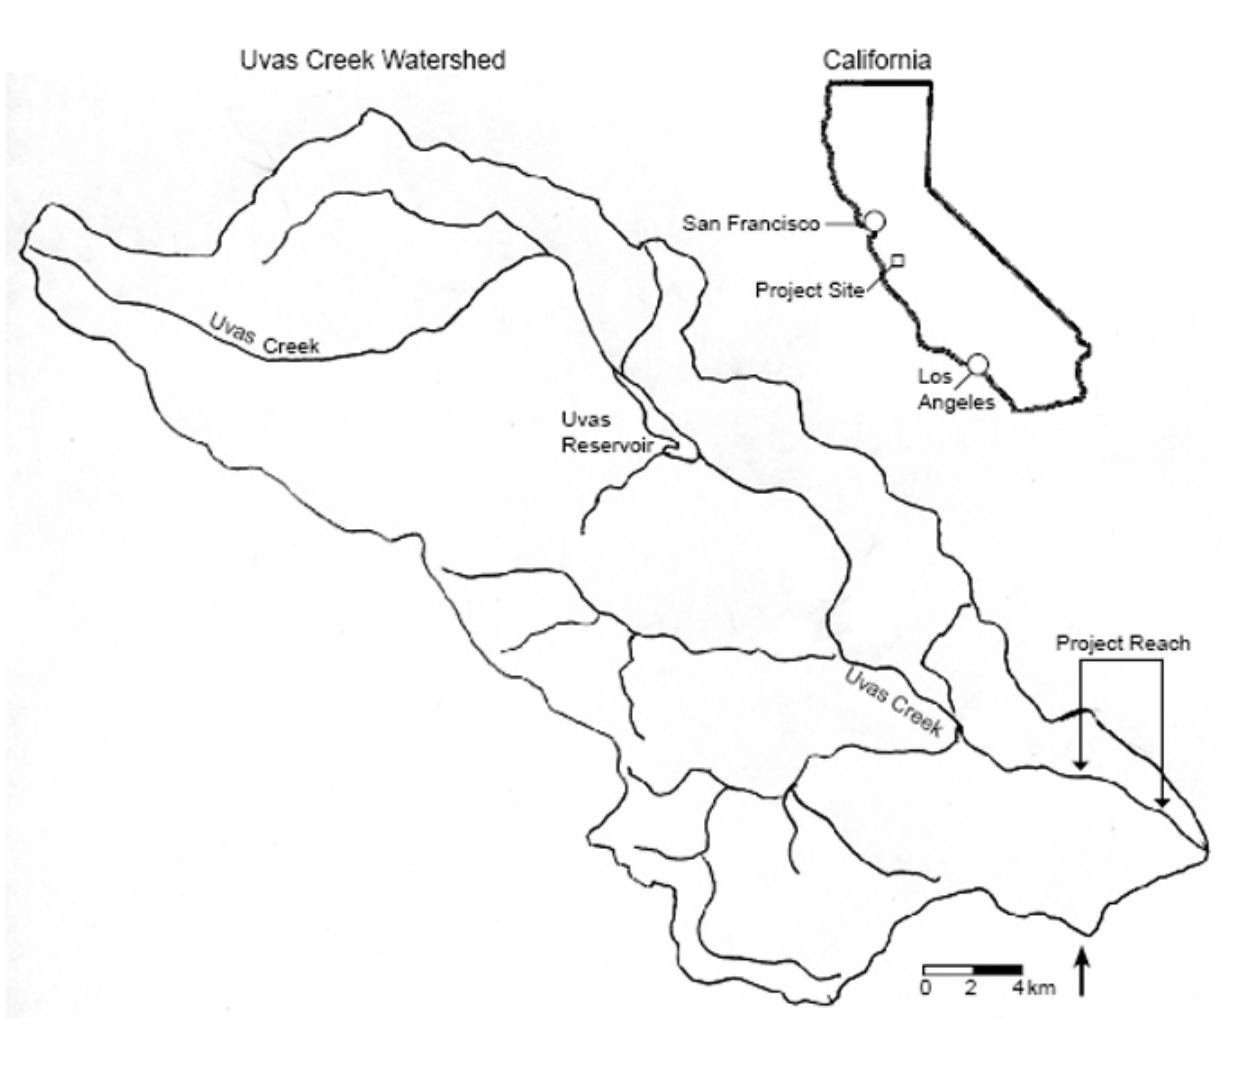
Fig. 6 . Location map, Uvas Creek (from Kondolf et al.